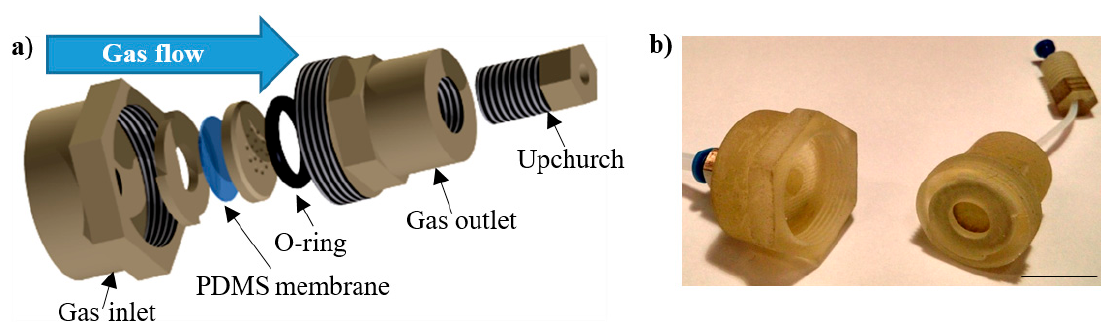
Figure 3. Three-dimensional printed microflow regulator providing gaseous media supply for the cultures on the LOC platform [30]: ( a ) schematic view, ( b ) regulator at a glance. Scale bar—1.5 cm. PDMS, polydimethylosiloxane.